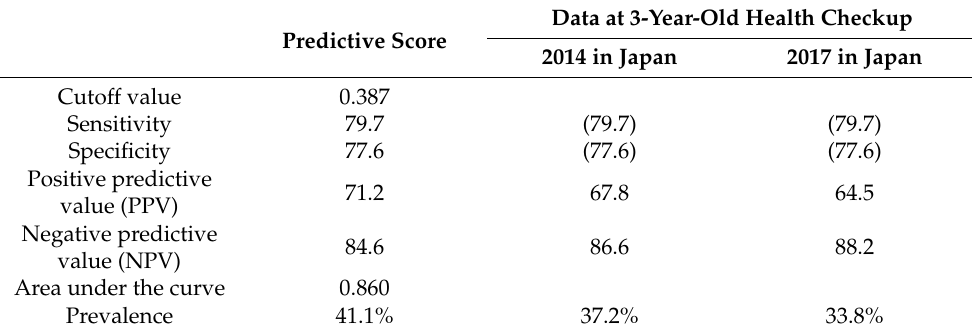
Table 3. Positive predictive value and negative predictive value by prevalence of having difficulties raising children at 3-year-old child health